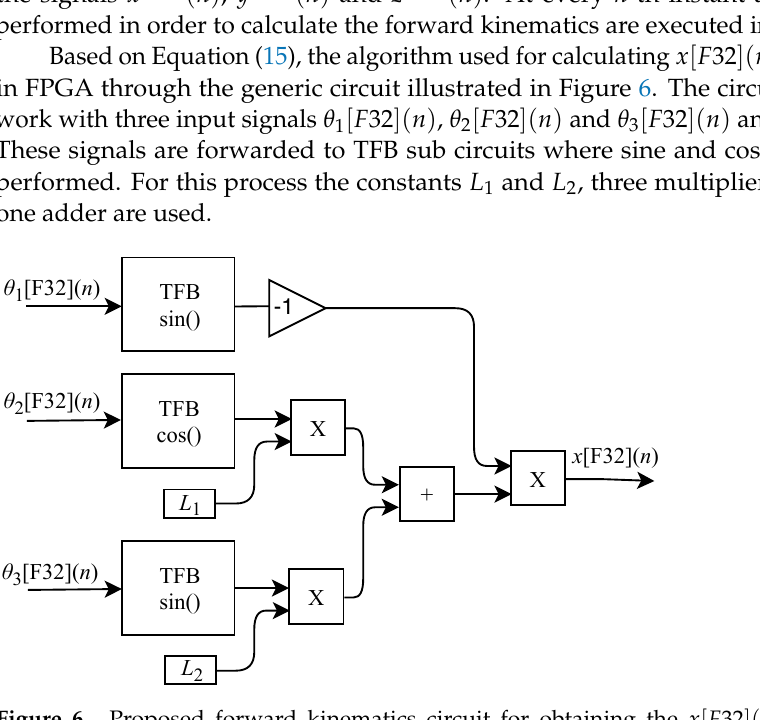
Figure 6. Proposed forward kinematics circuit for obtaining the x [ F 32 ]( n ) spatial coordinate (Equation (15))—FK-HMD and FK-HSD.